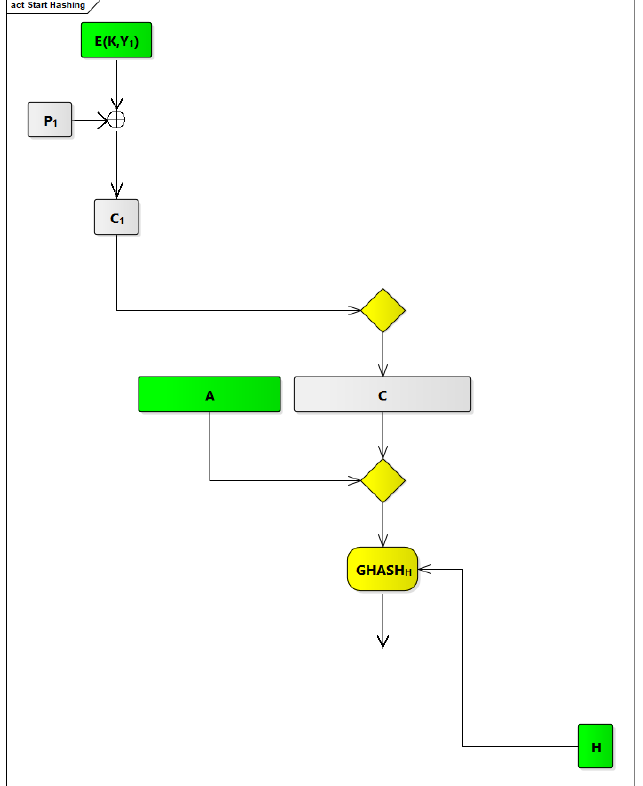
Figure 10. Start hashing instruction flow.